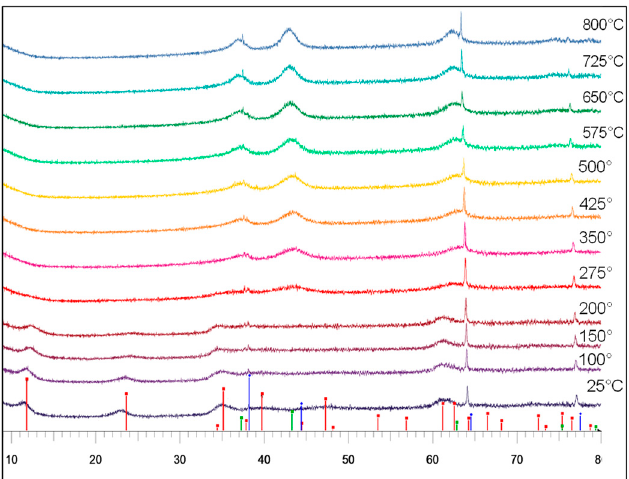
Figure 5. HT-XRD patterns of Ni 3 Fe LDH precursor decomposition in air.